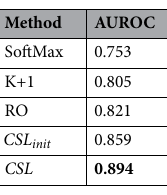
Table 3. Latent space initialization comparison. Significant values are in [bold].